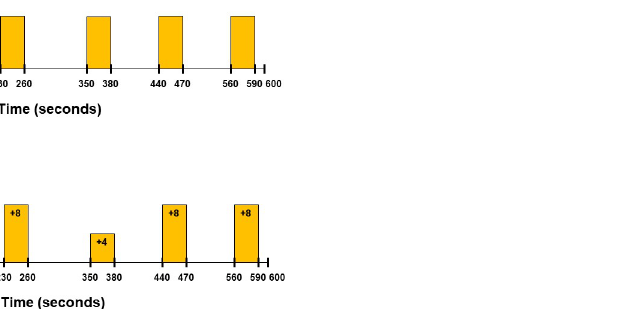
Fig 1. Paradigms of (A) breath hold and (B) exogenous CO 2 challenges. The timing for the onset and the end of breath hold epochs is the same as that for exogenous CO 2 hypercapnic epochs. The duration of normal breathing phases in breath hold challenge and normocapnic phases in exogenous CO 2 challenge varies from 60 seconds to 90